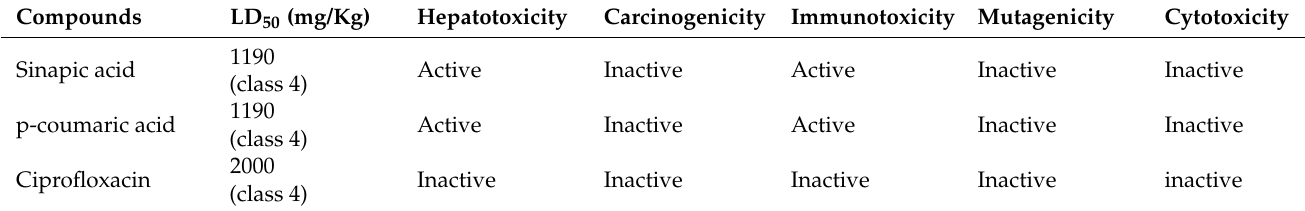
Table 3. Predicted toxicity results of the lead